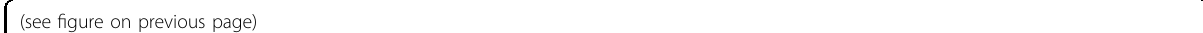
Fig. 3 mTOR inhibitors are more effective at inducing apoptosis of cancer stem-like cells than bulk tumor cells. a Flow plots for ALDH activity, CD44 expression and Annexin V (early marker of apoptosis) in UM-HMC-3B cells after 24 h of treatment with increasing concentrations of rapamycin, temsirolimus, cisplatin or paclitaxel analyzed by fl ow cytometry. Viable cells are represented in gray while apoptotic cells (i.e., high expression of Annexin V) are shown in red. b Graphs depicting the percentage of apoptotic cells (Annexin V-positive) according to ALDH activity and CD44 expression, i.e., ALDH high CD44 high , ALDH high CD44 low , ALDH low CD44 high , and ALDH low CD44 low after treatment with Rapamycin, temsirolimus, cisplatin, or paclitaxel. c Graph depicting the percentage of ALDH high CD44 high cells identi fi ed by fl ow cytometry in tumor cells (UM-HMC-3B) treated with increasing concentrations of rapamycin, temsirolimus, cisplatin, or paclitaxel. One-way ANOVA and post-hoc Tukey tests were used all statistical analyses included here. Different low-case letters indicate signi fi cant differences among groups ( P < 0.05), as determined by one-way ANOVA followed by post-hoc Tukey tests for multiple comparisons. Error bars indicate standard deviation (SD). Graphs for impacts of treatment on the fraction of ALDH high CD44 high or apoptotic cells depict data from four wells per experimental condition. Experiments were performed three independent times to verify reproducibility of the